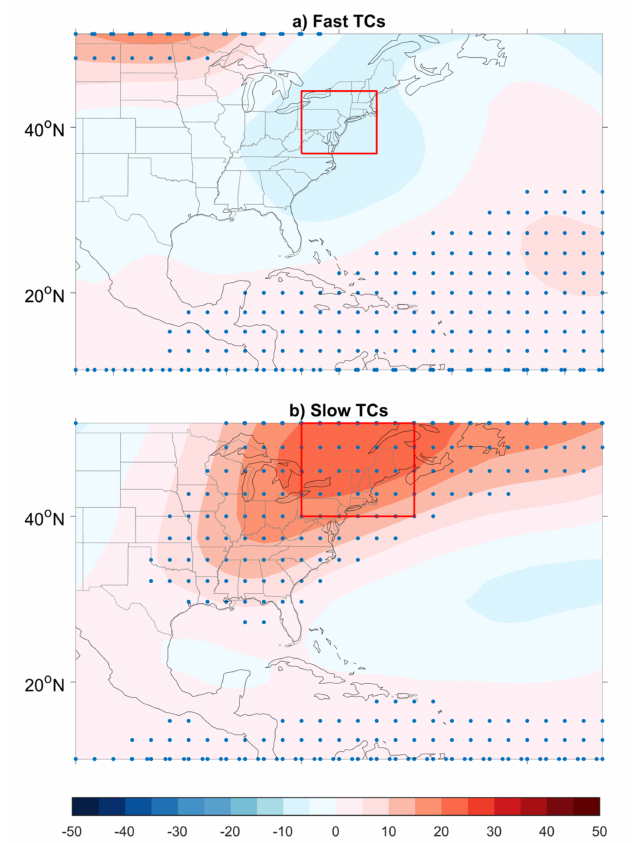
Figure 8. Composites of daily 500-hPa geopotential height anomaly one day before the fast- and slow-moving events. Stippled regions represent those significant at the 0.05 level based on the Student’s t